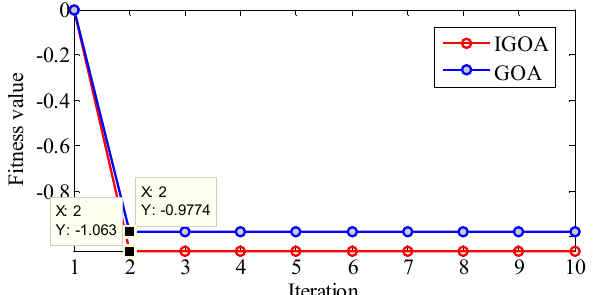
Figure 11. The optimization of TVF-EMD in the decomposition of simulation signal x ( t ) .